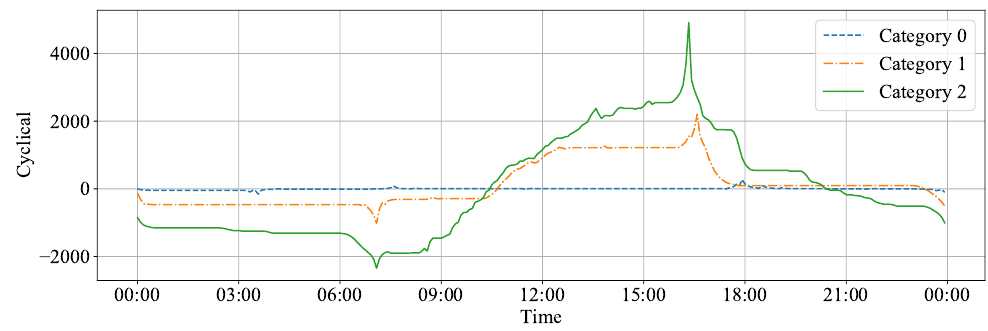
Figure 20. Centroid of cyclical component